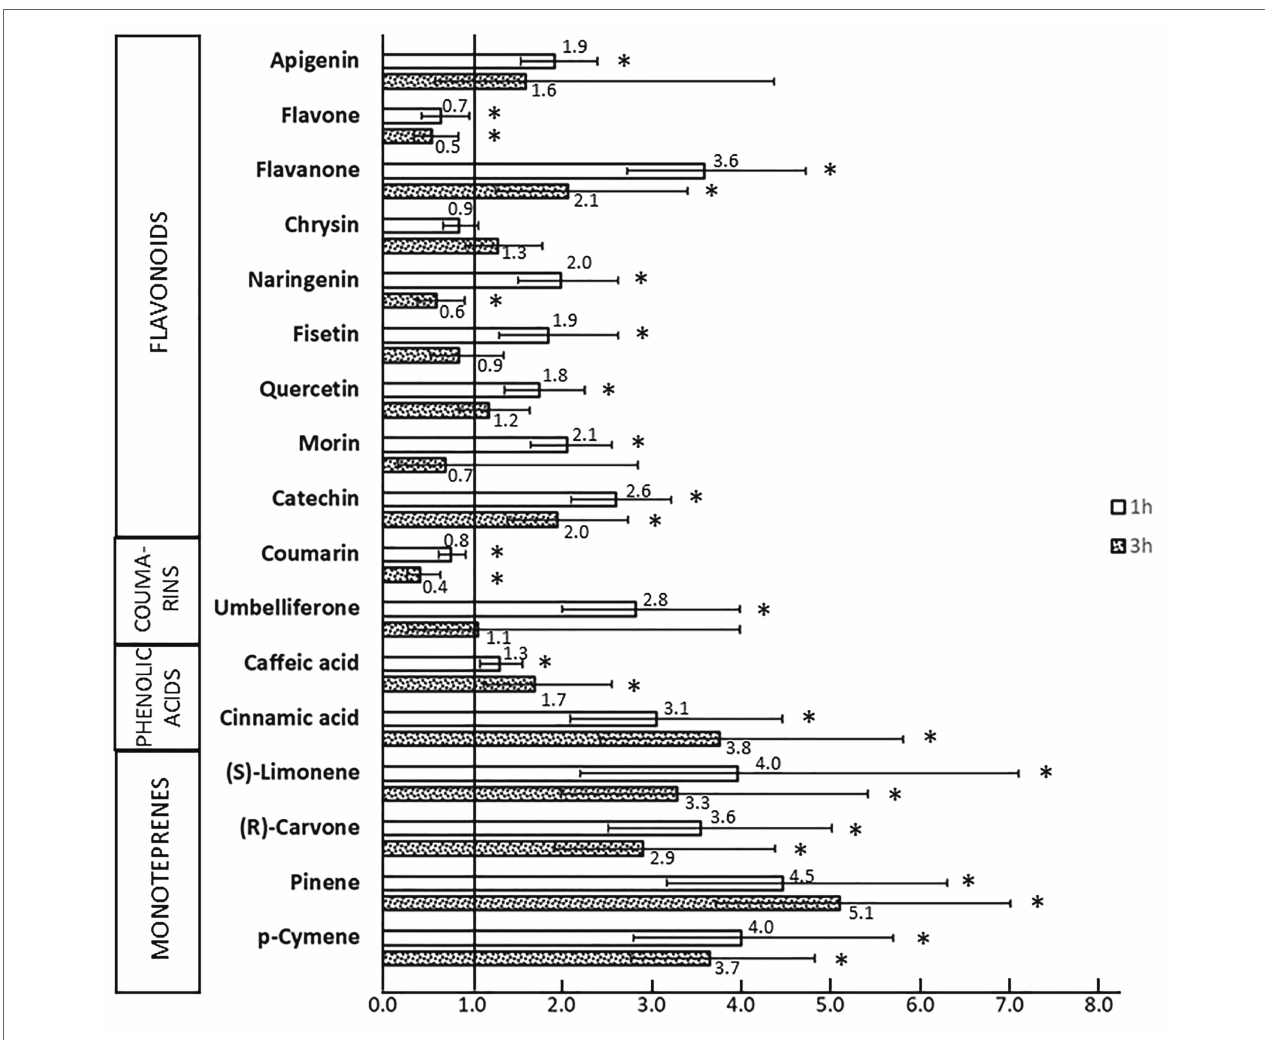
FIGURE 5 | Relative levels of bphA transcripts in JAB1 strain exposed to SPMs. JAB1 cells were exposed to individual 0.25 mM SPMs for 1 and 3 h; the level of bphA transcripts was quantified by quantitative reverse transcription-PCR (RT-qPCR). The 16S rRNA transcript was used as a reference. The levels of bphA transcripts are shown as the average fold change in the non-induced control (cells without SPMs added, induction rate equals 1) with 95%-confidence intervals. The obtained c p values were processed by the common base method according to Ganger et al. (2017). Asterisks ( ∗ ) denote a significant difference from the control as tested by t test ( α =